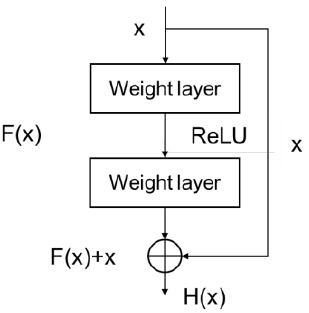
Figure 6. The structure of residual block.